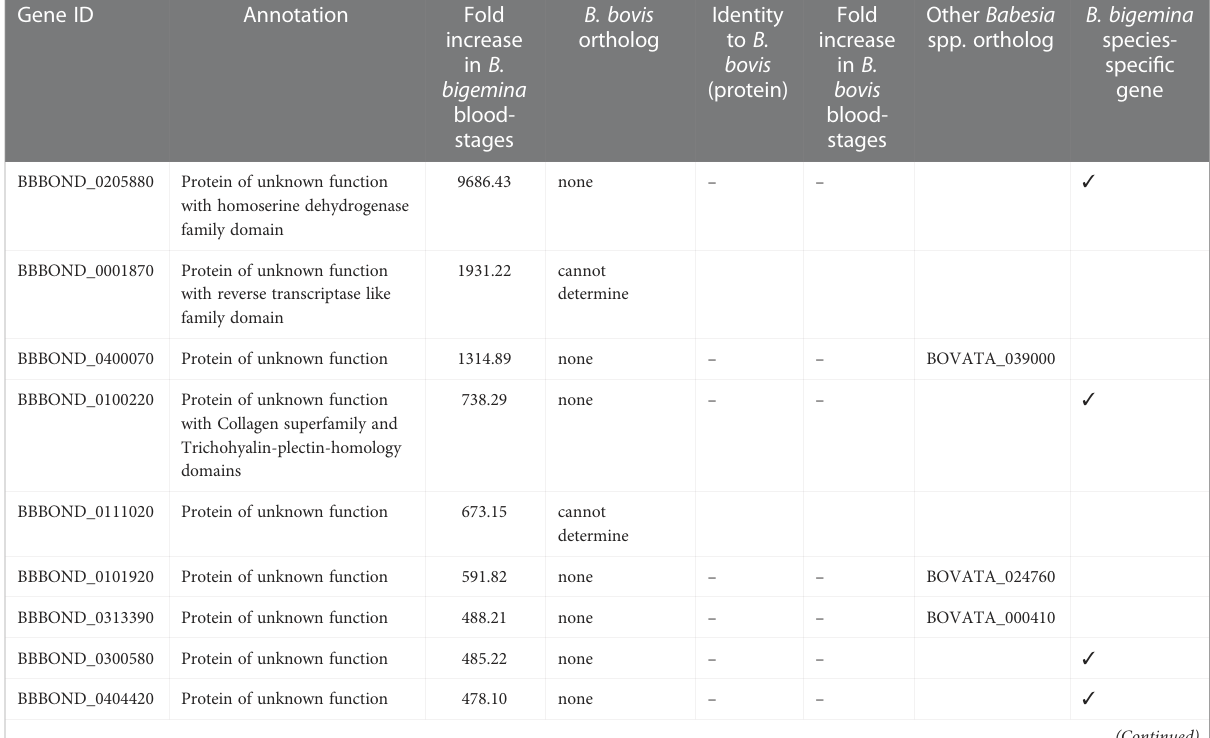
TABLE 3 Differential expression of genes with over 120-fold increase in B. bigemina blood-stages. Orthologs of these genes were found in B. bovis (BBOV) and B. ovata (BOVATA) by synteny using PiroplasmaDB. Gene